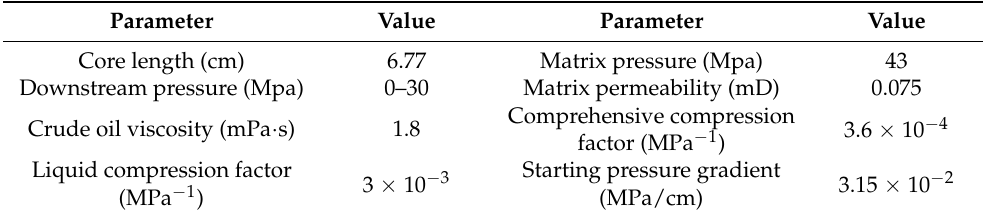
Table 2. Example parameters and